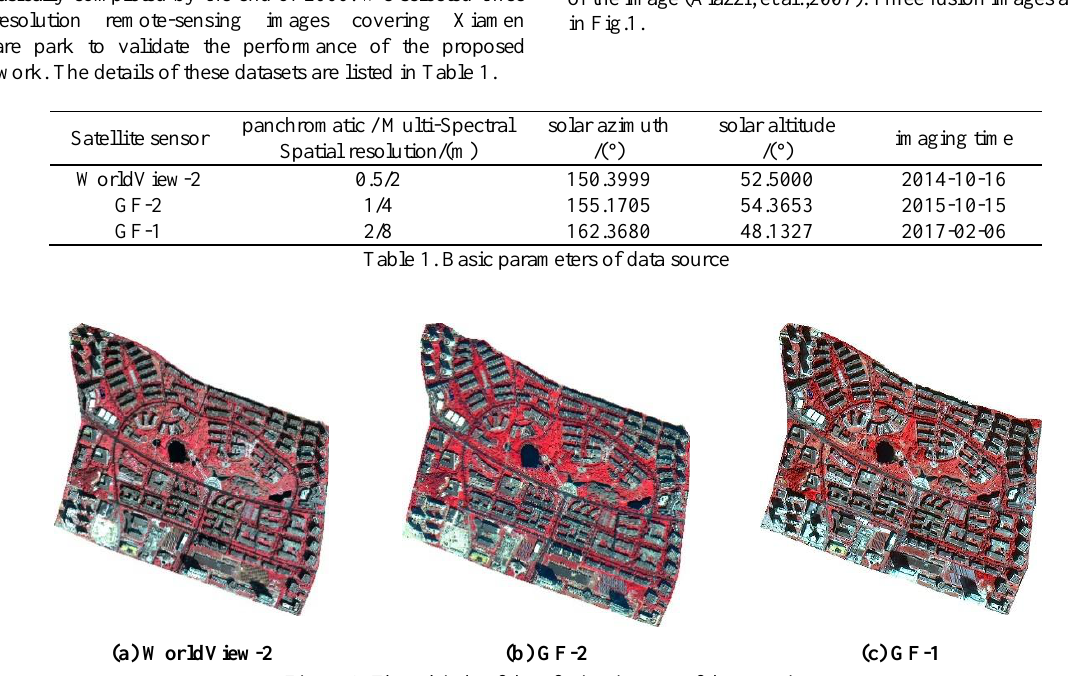
Figure 1. Three kinds of data fusion images of the test site